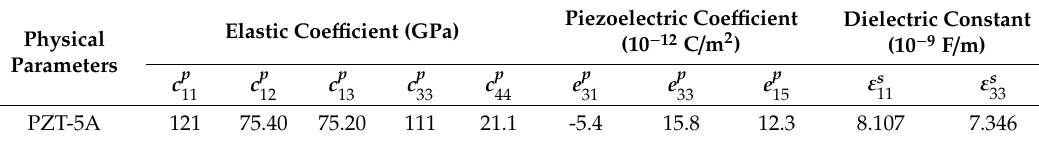
Table 2. Physical parameters of the piezoelectric patch (PZT-5A) [38].